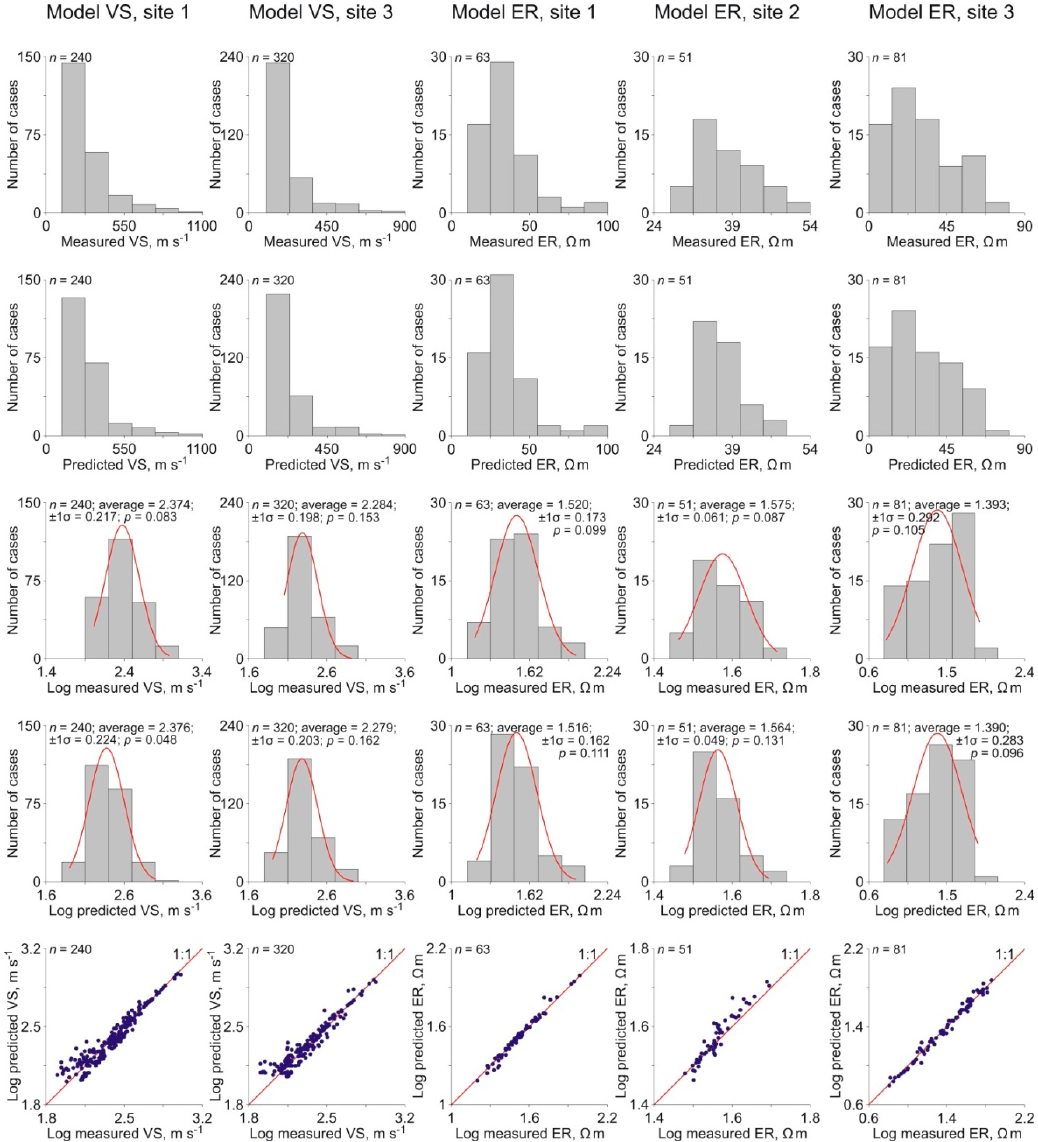
Figure 7. For VS and ER models in sites 1 to 3 (columns 1 to 5), histograms of measured (M) and predicted (P) data sets (rows 1 and 2), histograms of logarithmic M and P data sets with the fitted lognormal density functions (rows 3 and 4), and logarithm M vs. P data pairs with the 1:1 relationship. n = number of data. ±1 σ = standard deviation. p = p -value from a Kolmogorov–Smirnov goodness-of-fit test.